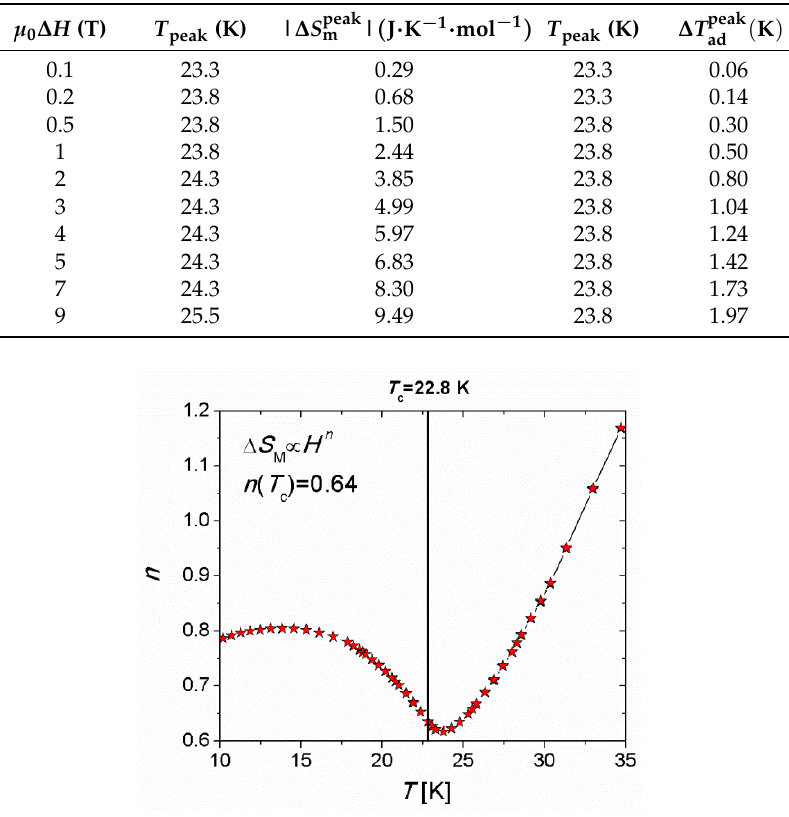
Figure 12. Temperature dependence of exponent n for 2 .